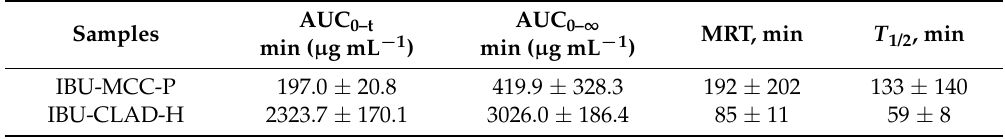
Figure 7. In vivo IBU plasma concentration in rats at 30 mg/kg dose from IBU-MCC-P and IBU-CLAD-H 10% w / w mixtures. The results are the average of three measurements with standard deviation as error bars. The lines are guide for the eye. Table 4. Pharmacokinetic parameters for IBU 10% w / w mixtures at 30mg/kg dose in rats. The results are average of three measurements with standard error.